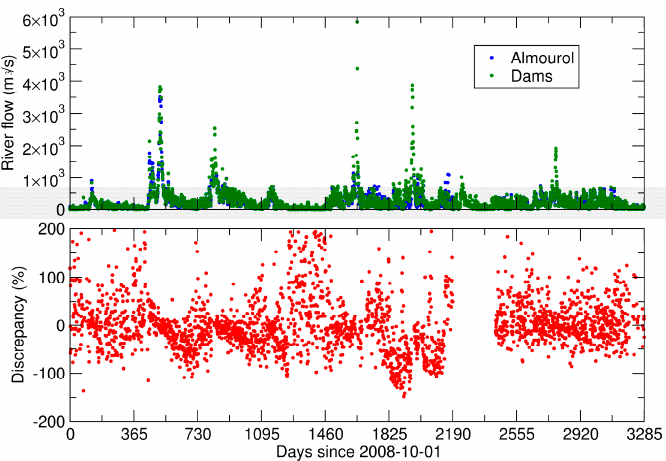
Figure 4. Comparison between two estimates—Almourol and sum of the outflow from the Castelo de Bode and Belver dams – of the mean daily river flow reaching the estuary for the hydrological years 2008–2009 through 2016–2017. The discrepancy is evaluated as the di ff erence between the two time series scaled by their average. Geosciences 2019 , 9 , x FOR PEER REVIEW